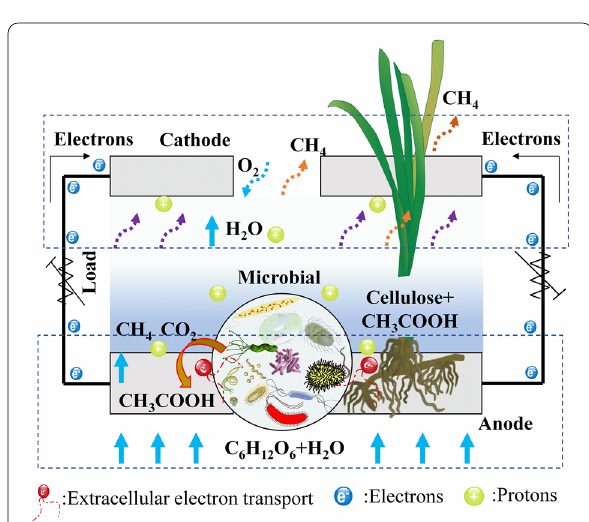
Fig. 9 Mechanism diagram of carbon conversion and CH 4 emission in the